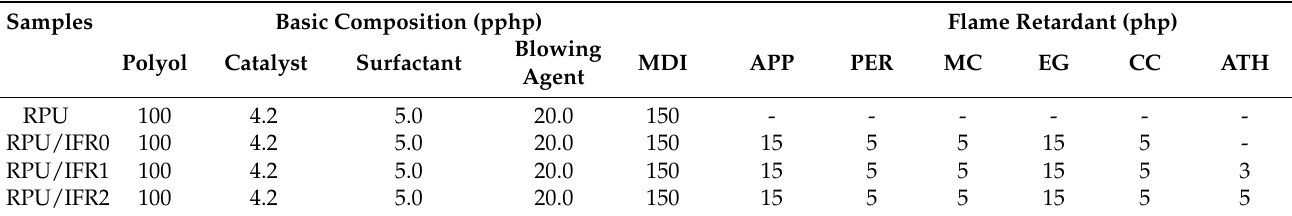
Table 2. Preparative parameters of flame retardant RPU foam